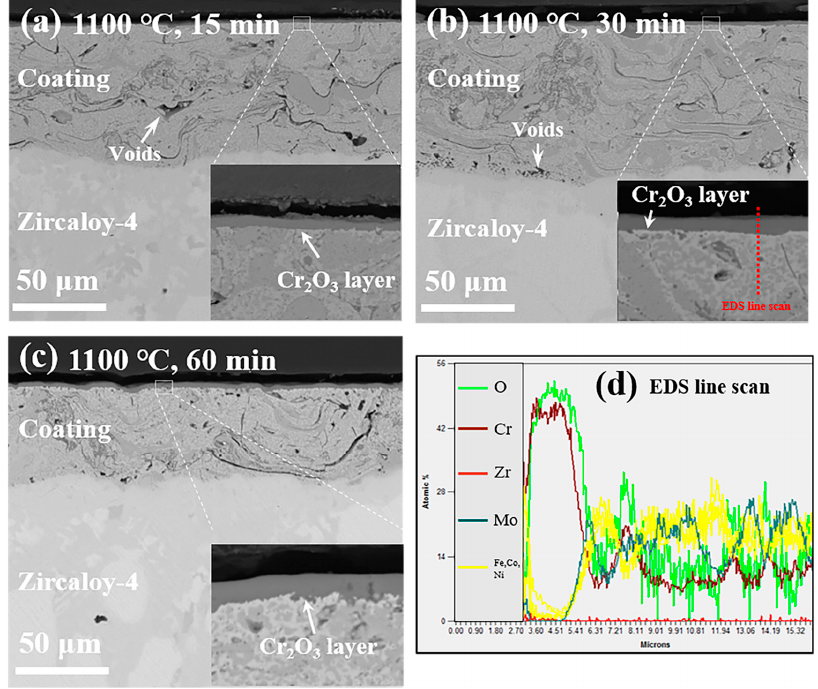
Figure 9. Cross ‐ sectional SEM images of the FeCoNiCrMo coatings after oxidation at 1100 °C for 15 min ( a ), 30 min ( b ), and 60 min ( c ) in a steam environment and the line scans ( d ) of the oxide layer for 15 min.